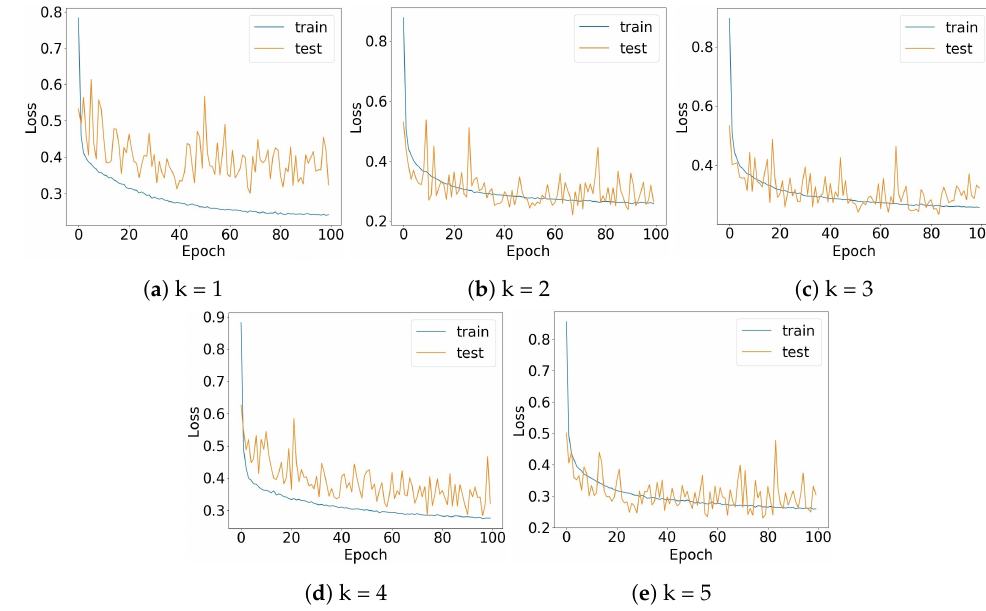
Figure 14. Training and testing loss of the EMN model in all the 5-fold cross validation along 100 epochs. Orange lines show the test losses while the blue lines show the training